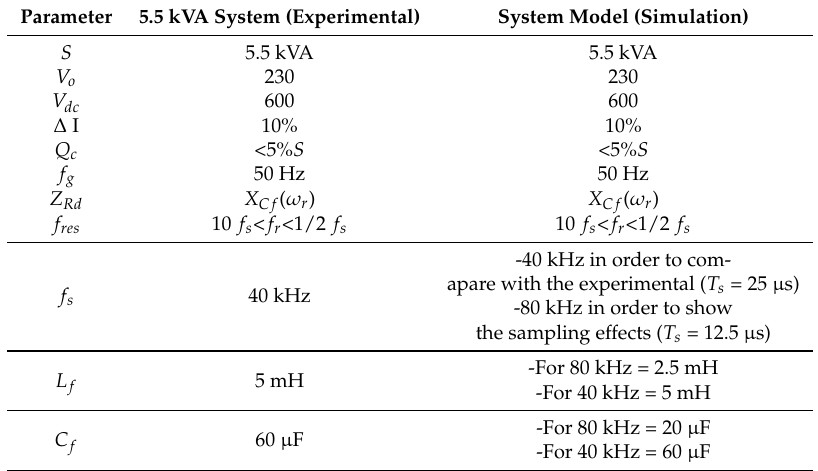
Table 1. Filter design parameters for the simulation and experimental